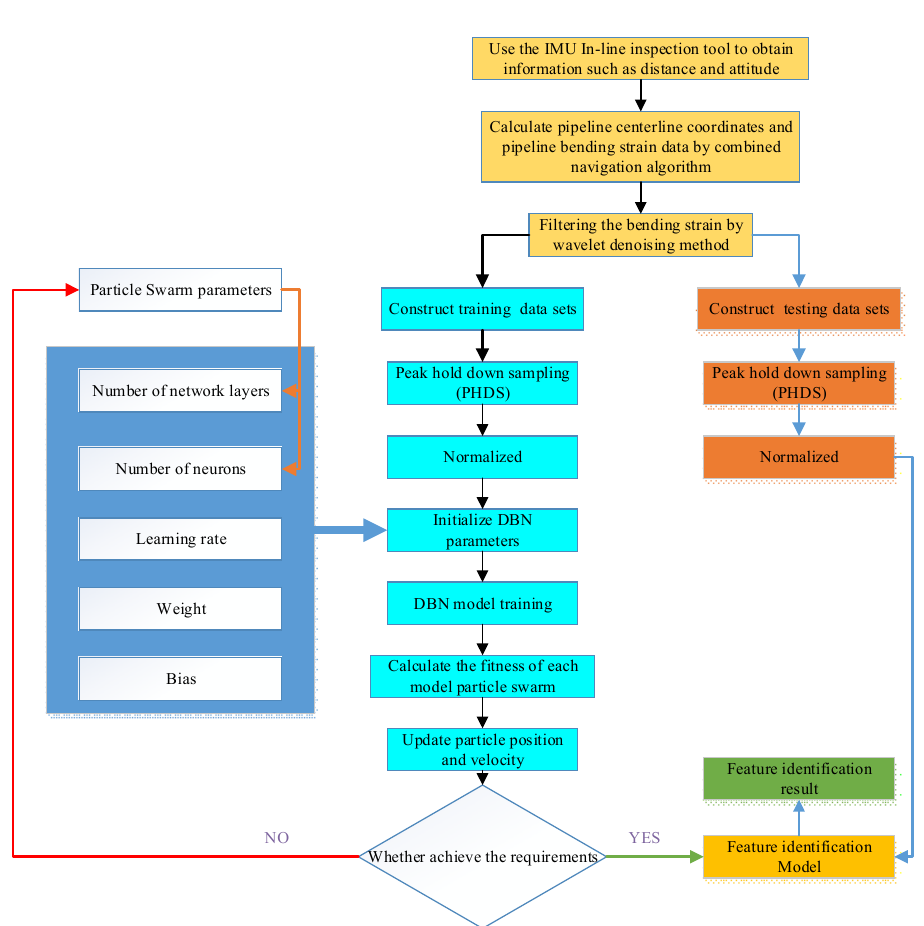
Figure 5. Flow chart of the method proposed in this work.